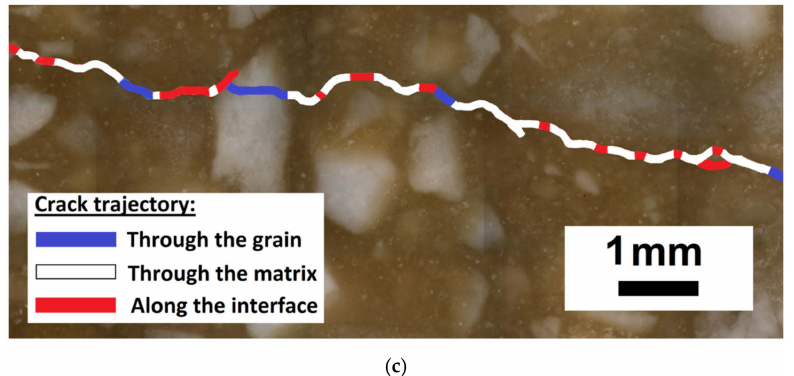
Figure 3. Examples of the fracture pattern obtained with Drucker–Prager criterion ( a ), combined Drucker–Prager–Rankine criterion ( b ), and a tensile crack formed in a sample of silica refractory under monotonic wedge splitting loading ( c ). The thick curved line in ( c ) shows the crack trajectory. White, blue, and red portions of the crack lines indicate crack propagation through matrices, through grains, and along interfaces, respectively. The width of each image represents 1 cm of the sample.